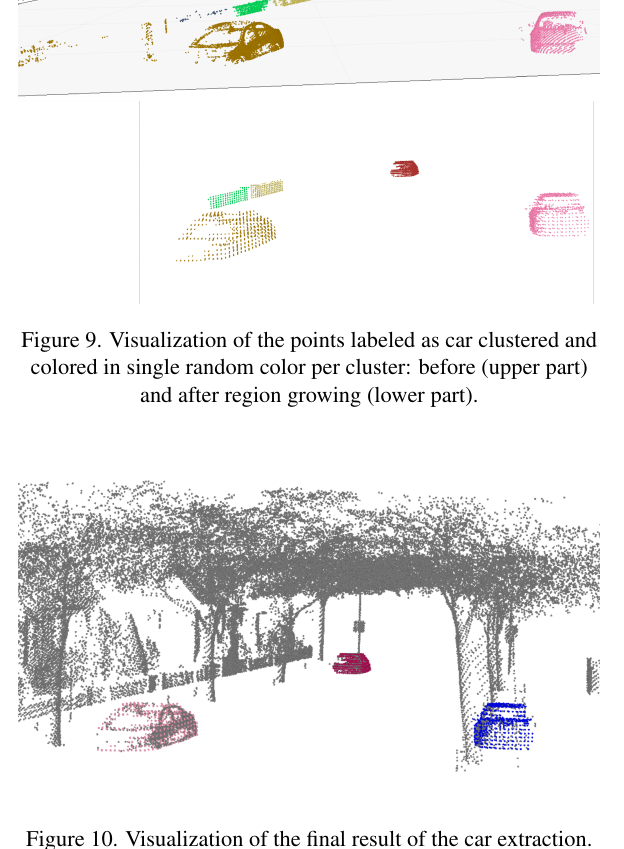
Figure 10. Visualization of the final result of the car extraction. The points are colored in single random color per car instance.